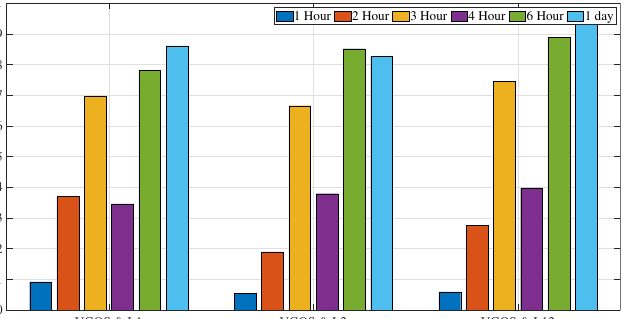
Figure 12. Correlation coefficient of VGOS and legacy solutions for different sub-daily resolutions (analysis performed during five